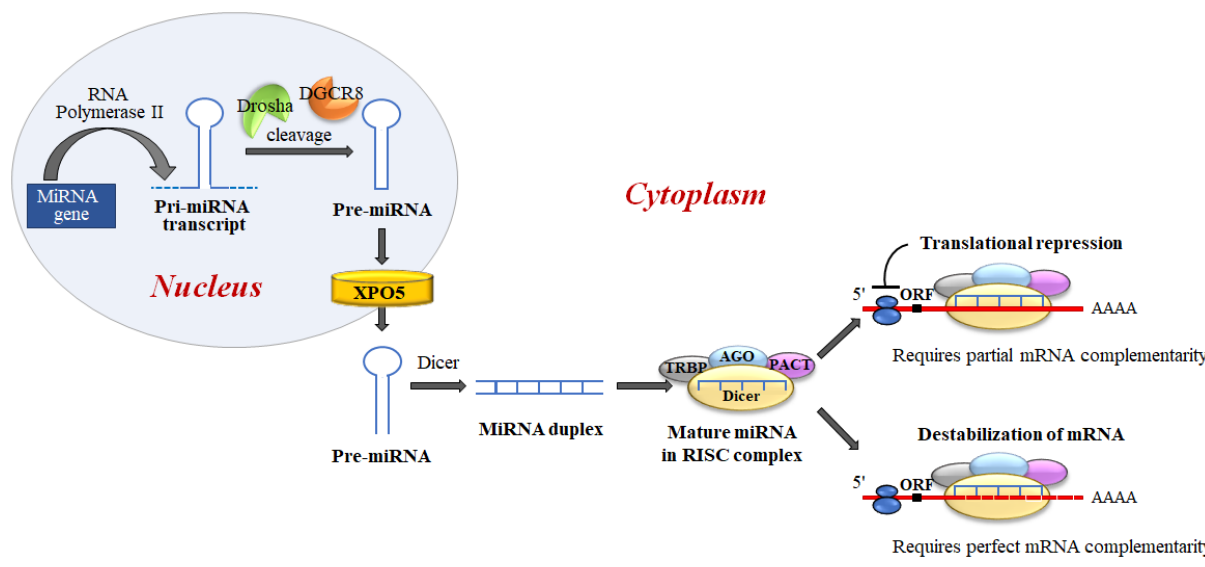
Figure 6. MiRNA biogenesis and miRNA regulation of gene expression. miRNAs are generated, in the nucleus, as primary transcripts (pri-miRNA) by RNA polymerase II/III. The miRNA precursor (pre-miRNA) is processed by Drosha, an RNase III enzyme, and by two molecules of a protein known as Pasha (DGCR8). DGCR8 contains an RNA-binding domain that binds the primary pri- miRNA to stabilize it for processing by Drosha. Drosha and DGCR8 homeostatically control miRNA biogenesis by an auto-feedback loop. After processing, pre-miRNAs, of approximately ~60–80 nt, are exported into the cytoplasm by Exportin-5 (XPO5). Next, the mature miRNA released by the Dicer endonuclease is assembled into the RNA-induced silencing complex (RISC). RISC directs its bound miRNA to untranslated regions of the partially complementary 3′mRNA, resulting in translation inhibition or targeted destruction of the mRNA. MiRNAs regulate target mRNA expression through two major mechanisms: translation blocking in the initiation step or the elongation phase; and removal of the polyA tail promoting deadenylase activity followed by mRNA degradation.